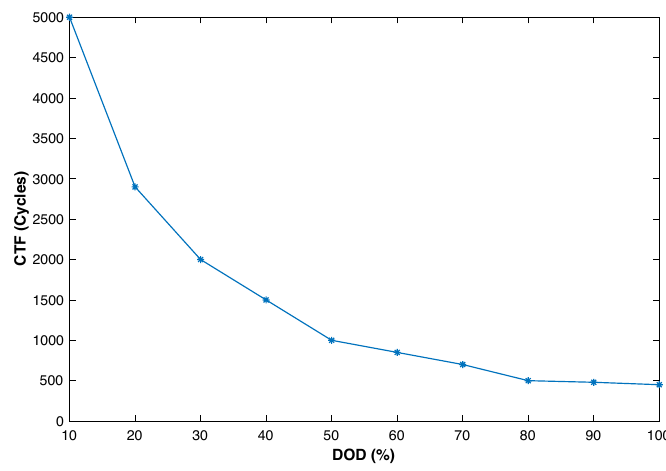
Figure 1. The relationship between CTF and